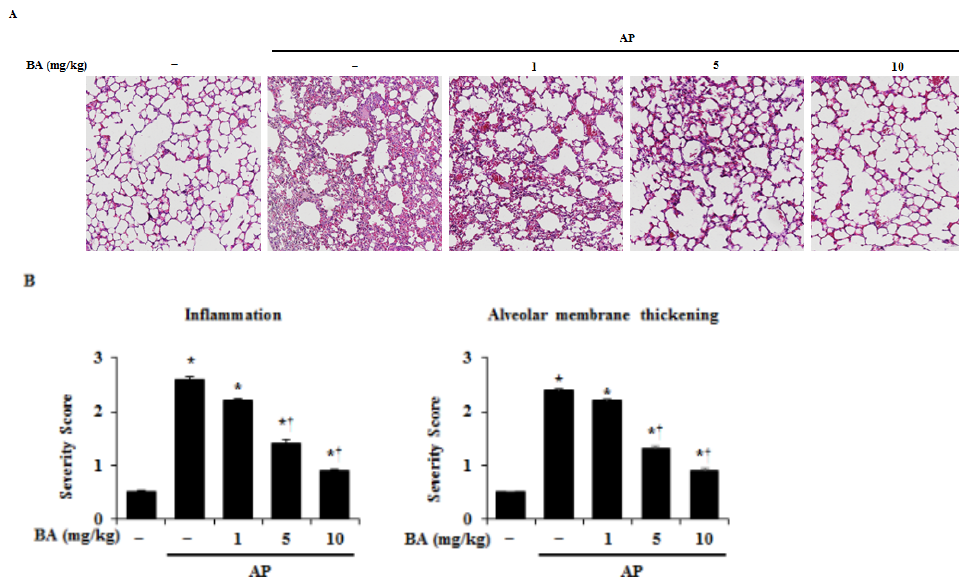
Figure 2. Effect of betulinic acid (BA) on lung histological damage in cerulein-induced acute pancreatitis (AP). ( A ) Representative hematoxylin and eosin (H&E)-stained lung tissue section (200 × magnification). ( B ) Histological sections of lung tissue were scored from 0 (normal) to 3 (severe) for inflammation and alveolar membrane thickening. Data have been represented as mean ± SEM for six mice in each group. Results are representative of three experiments. * p < 0.05 vs. DMSO treatment alone. † p < 0.05 vs. cerulein treatment alone.